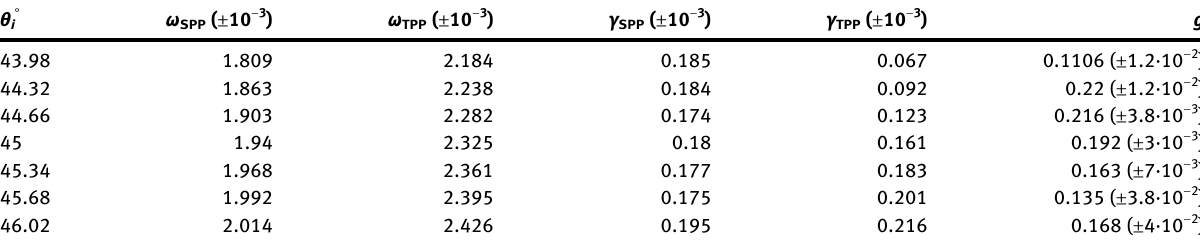
Table  : Fitting parameters of the p -polarized re fl ection spectra at different angles of incidence ( θ i ). Parameters ω SPP and ω TPP are the resonance frequencies (eV), γ SPP , γ TPP (eV) are the damping terms (FWHM) of the hybrid mode excitations h-SPP and h-TPP, respectively, and the parameter g indicates the coupling